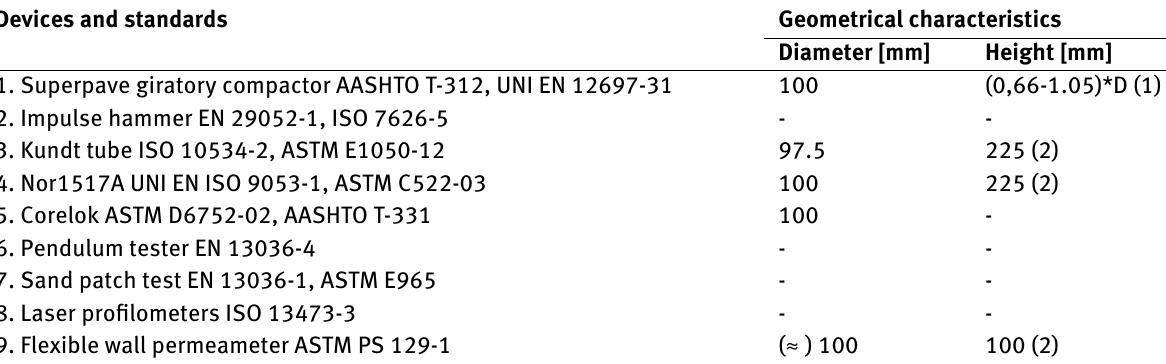
Table 4: Geometric characteristics of the specimen for device Devices and